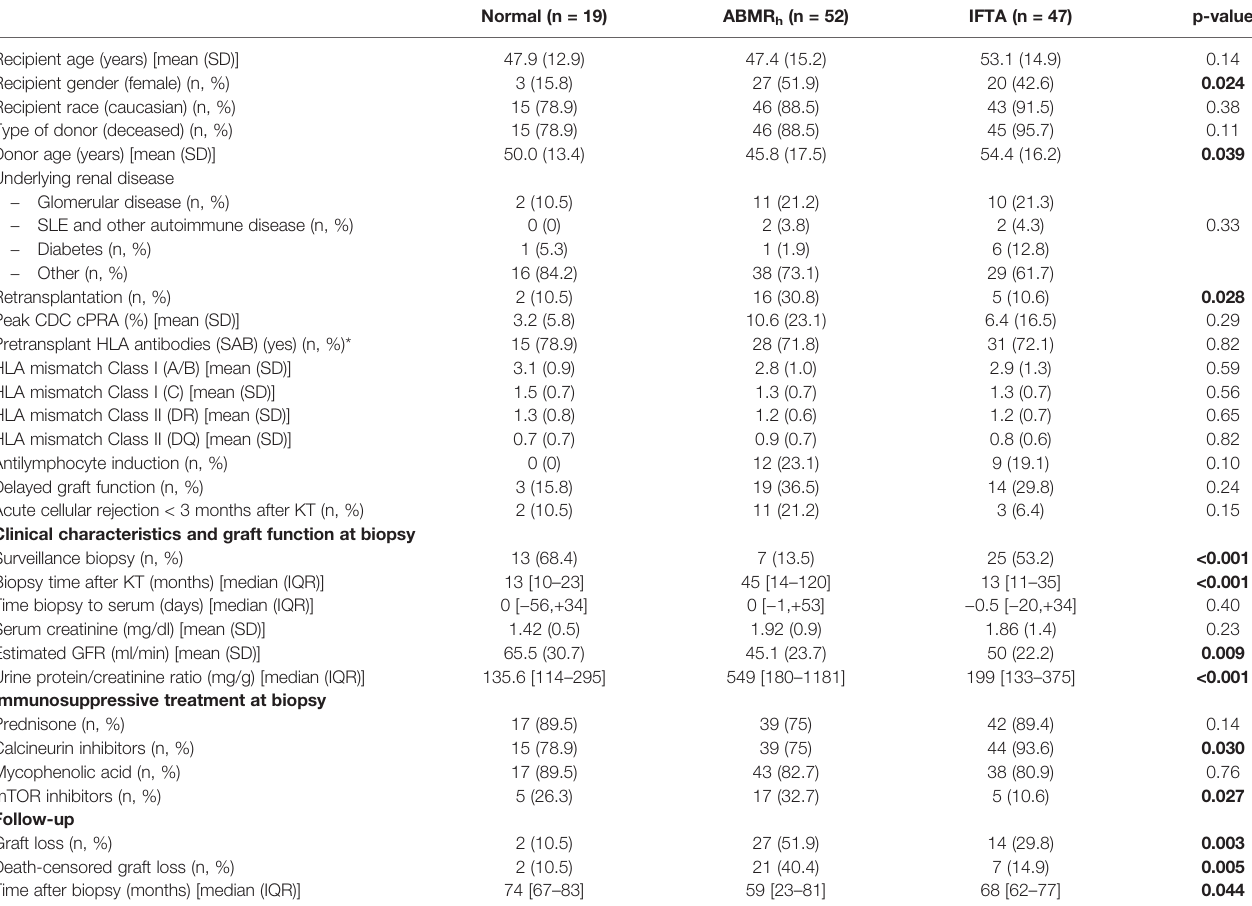
TABLE 1 | Demographics and clinical characteristics of all included